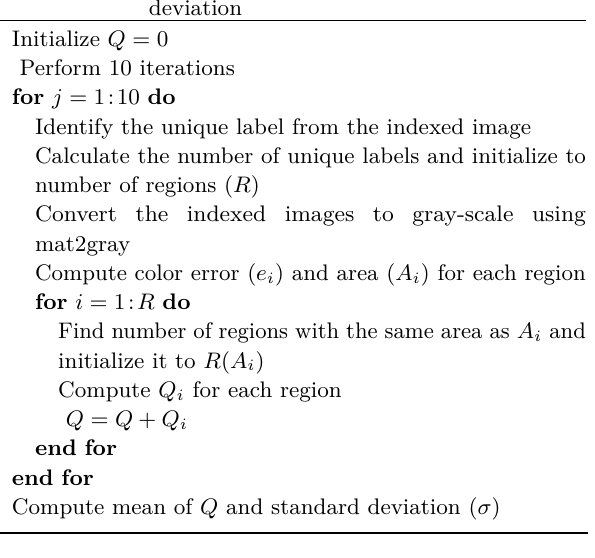
Algorithm 4 Pseudocode for computation of